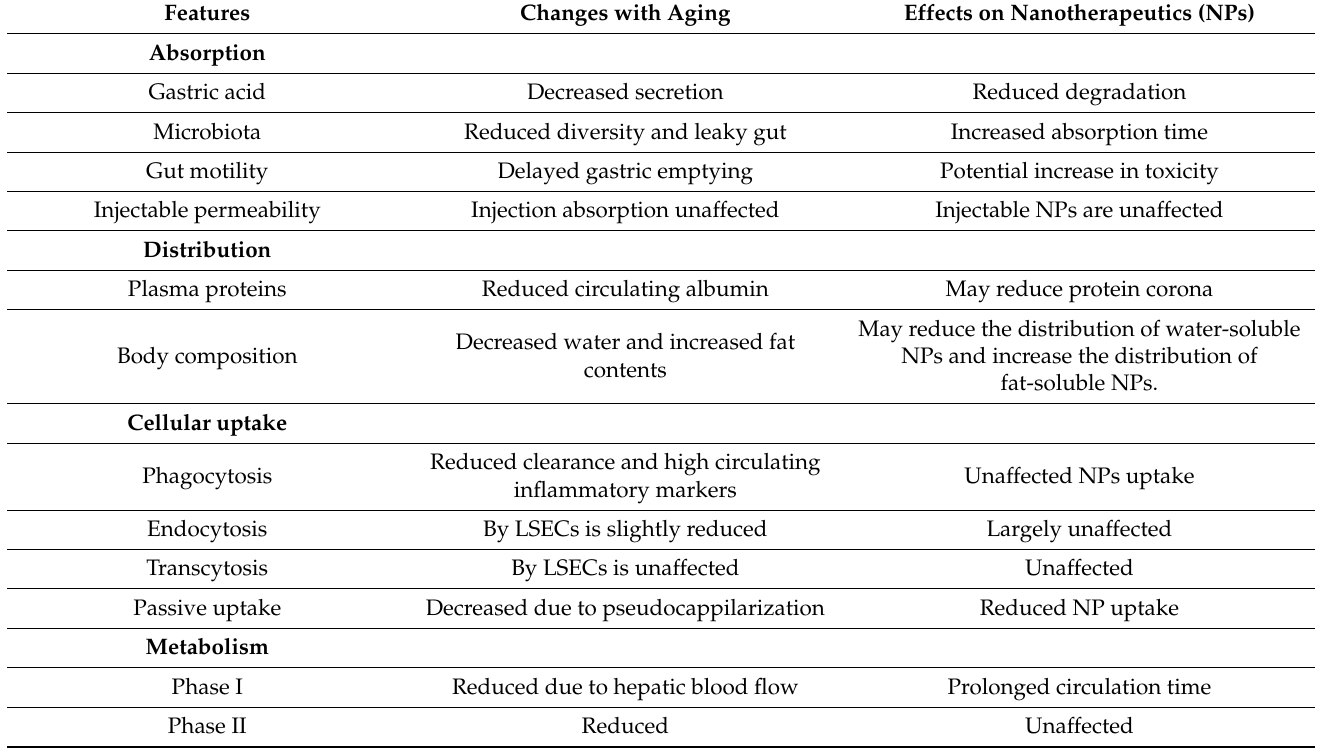
Table 1. Summary of the changes with aging on drug deposition and the effect on